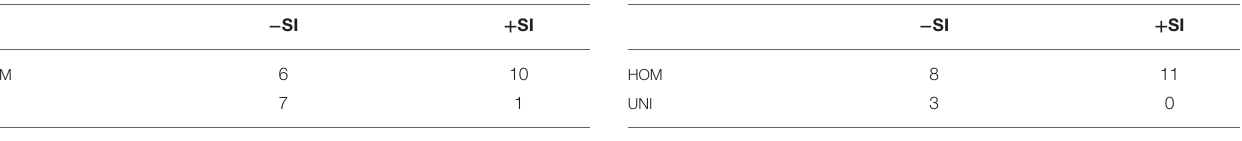
TABLE 5 | Count of group assignments (argmax g p ( γ ( s ) = g | Y )) for adults in Experiment